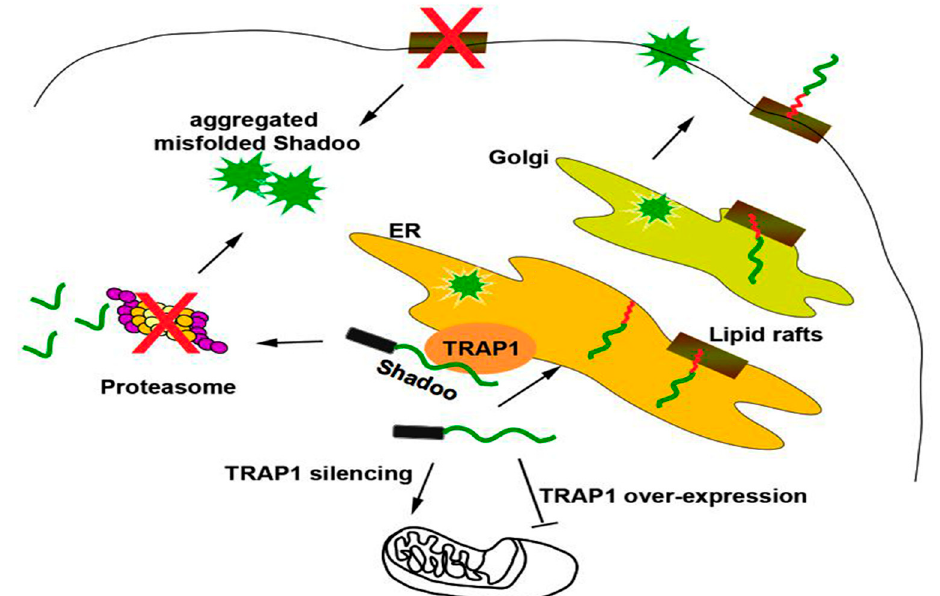
Figure 4. The molecular chaperone TRAP1 controls the dual ER/mitochondrial targeting of Shadoo. Shadoo is a secretory GPI-AP which is partially localized in the ER. In neuronal cells, Shadoo exhibits a strong tendency to misfold and contrary to canonical secretory proteins, it follows a dual targeting to ER or mitochondria regulated by the mitochondrial chaperone TRAP1 at the interface between ER/mitochondria. The folding properties of Shadoo are partially dependent on association to lipid rafts, whose alteration, as well as proteasomal block, induces its misfolding. Black rectangle: signal peptide; red “ zig-zag ” line: GPI-anchor. Arrows point to directionality of protein trafficking.